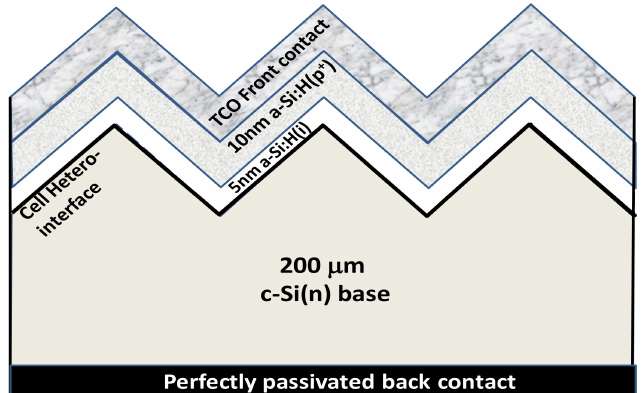
Figure 1. Silicon hetero-junction (SHJ) solar cell under study (simulations done with TCO